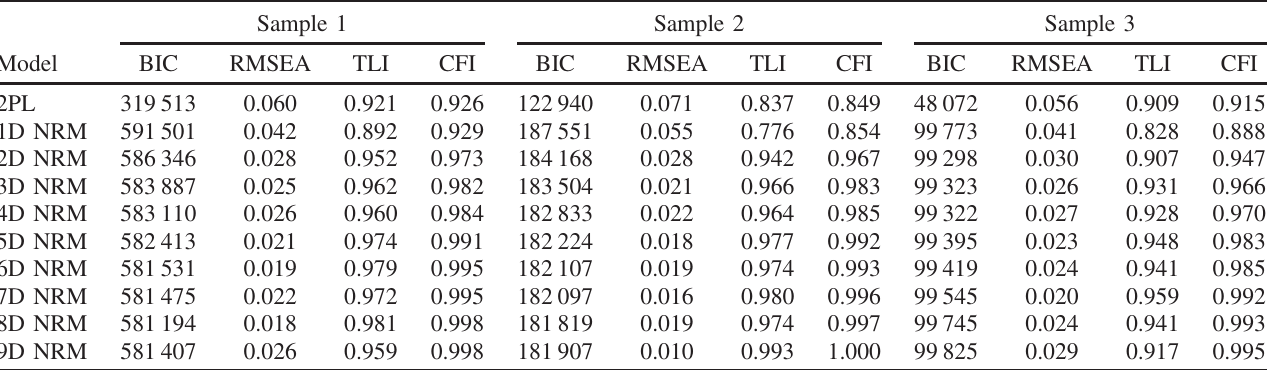
TABLE II. Model fit statistics for individual